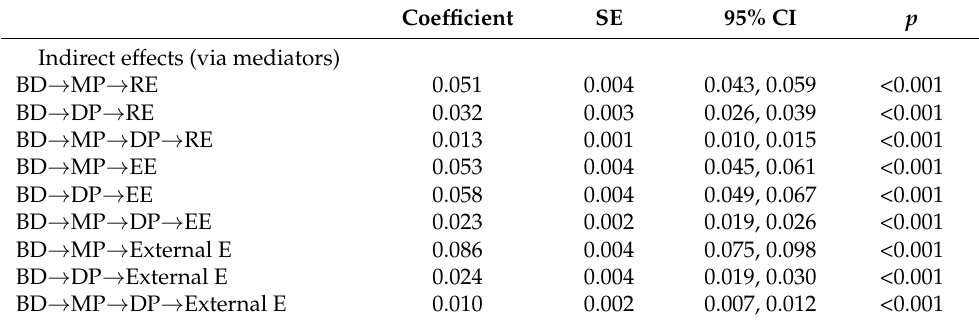
Table 2. Summary of indirect effects from body dissatisfaction to disordered eating behaviors.